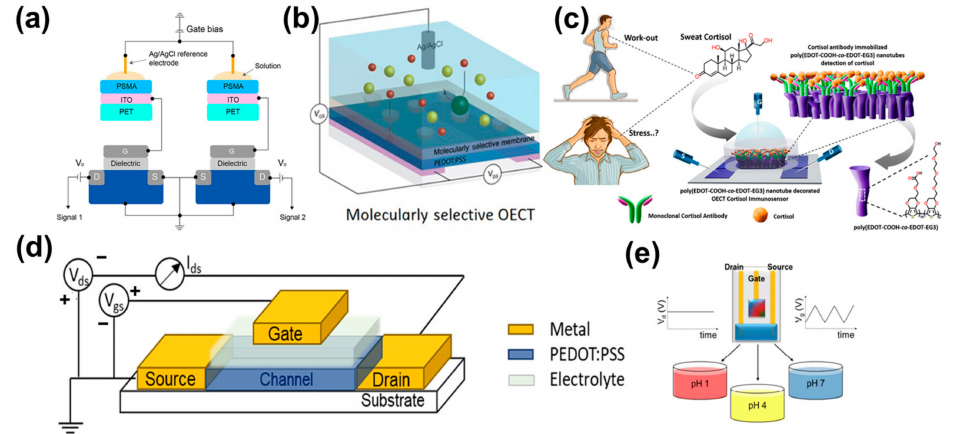
Figure 4. ( a ) With two different remote sensing principle diagrams of the gauging system of the door. ( b ) The schematic representation of molecularly selective membrane (MSM) in combination with the OECT device. ( c ) Development of a process illustration for OTFTs based on detecting cortisol concentrations in sweat. ( d ) Typical OECT configuration. ( e ) Scheme of the potentiodynamic approach. ( a ) Reproduced with permission [34]. Copyright 2018, American Chemical Society. ( b ) Reproduced with permission [37]. Copyright 2018, American Association for the Advancement of Science. ( c ) Reproduced with permission [38]. Copyright 2022, American Chemical Society. ( d ) Reproduced with permission [39]. Copyright 2018, American Chemical Society. ( e ) Reproduced with permission [39]. Copyright 2018, American Chemical